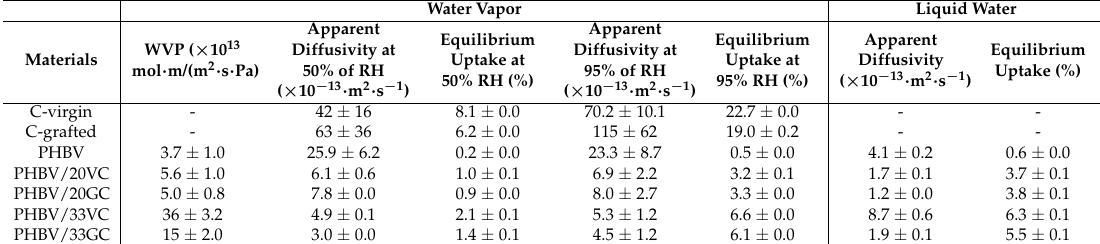
Table 3. Water vapor permeability (WVP), water vapor and liquid water diffusivity, and equilibrium uptake in PHBV-based